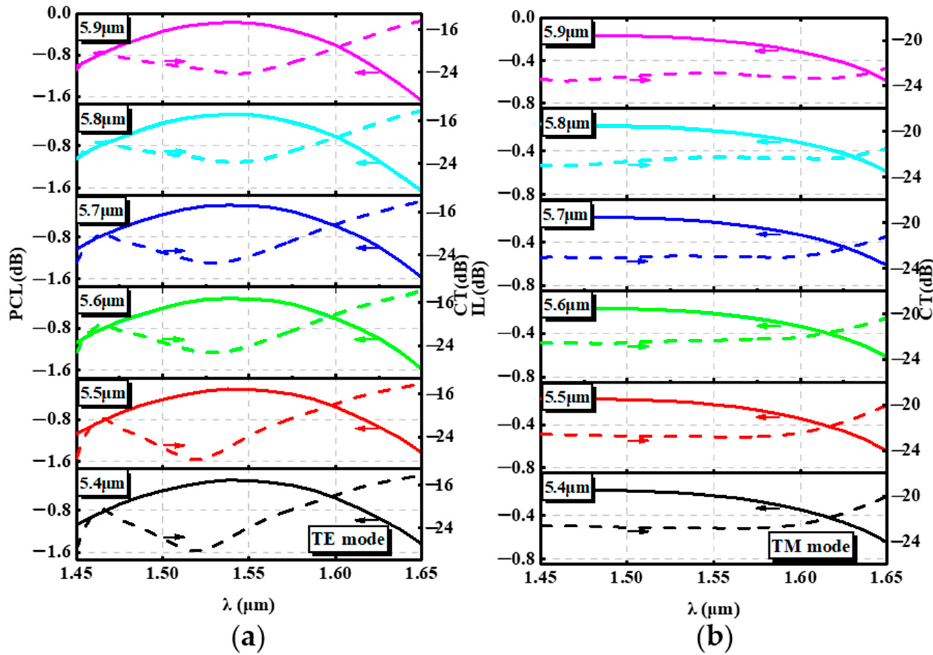
Figure 6. ( a ) PCL and CT of the PSR with different L 2 from 1.45 µ m to 1.65 µ m. ( b ) IL and CT of the PSR with different L 2 from 1.45 µ m to 1.65 µ m.